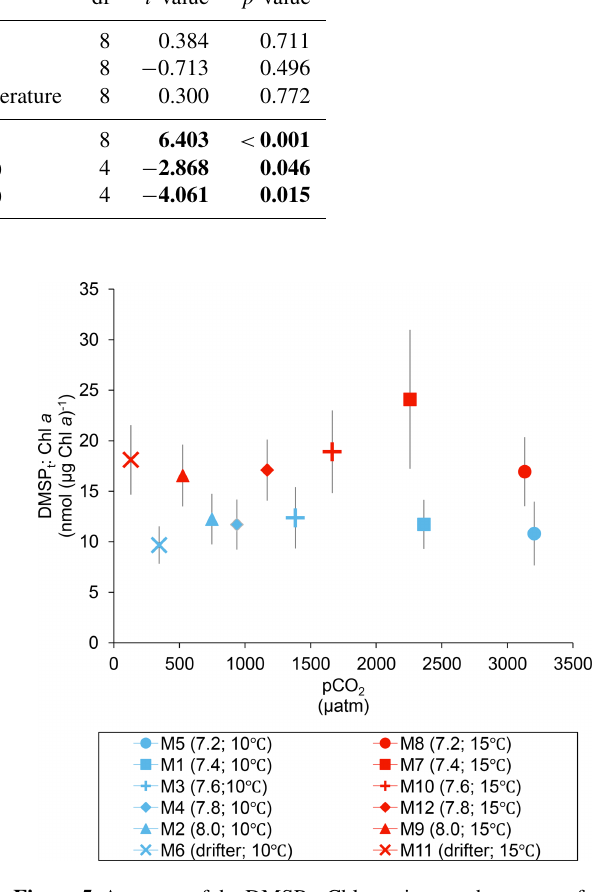
Figure 5. Averages of the DMSP t : Chl a ratio over the course of the experiment (day 0 to day 13). For symbol attribution to treatments, see the